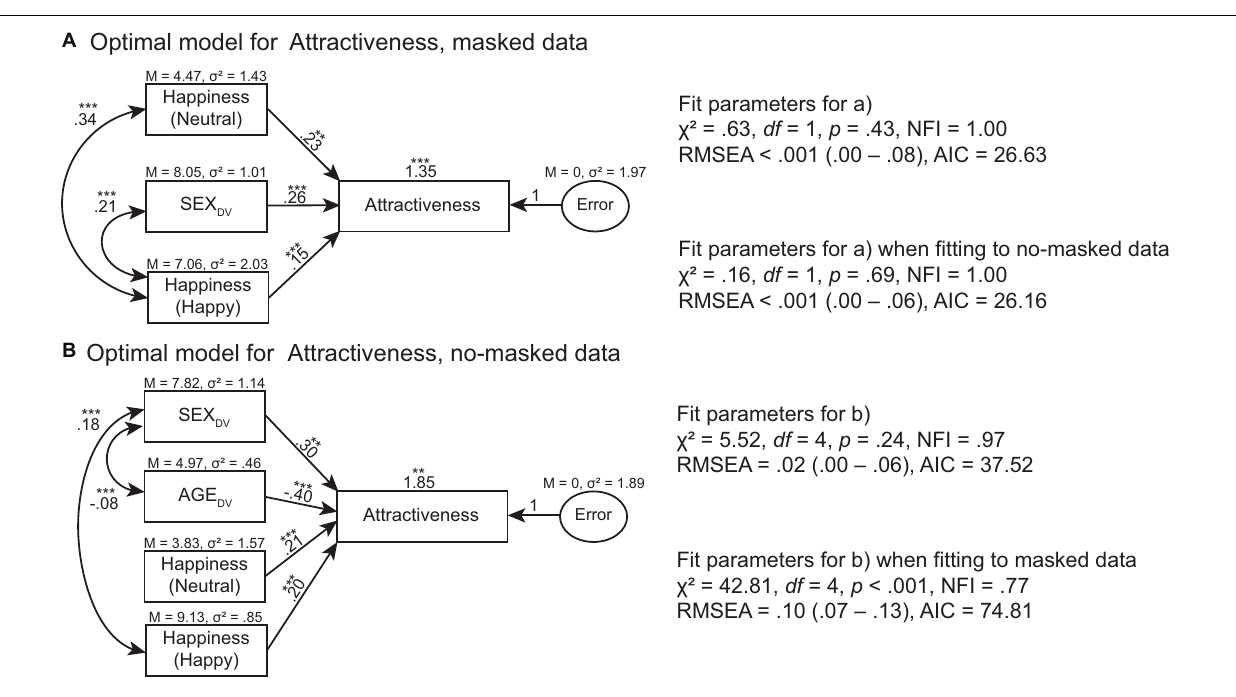
FIGURE 7 | Optimal models of Attractiveness for (A) masked face data and (B) no-masked face data. *** p > 0.001, ** p > 0.01, * p > 0.05.